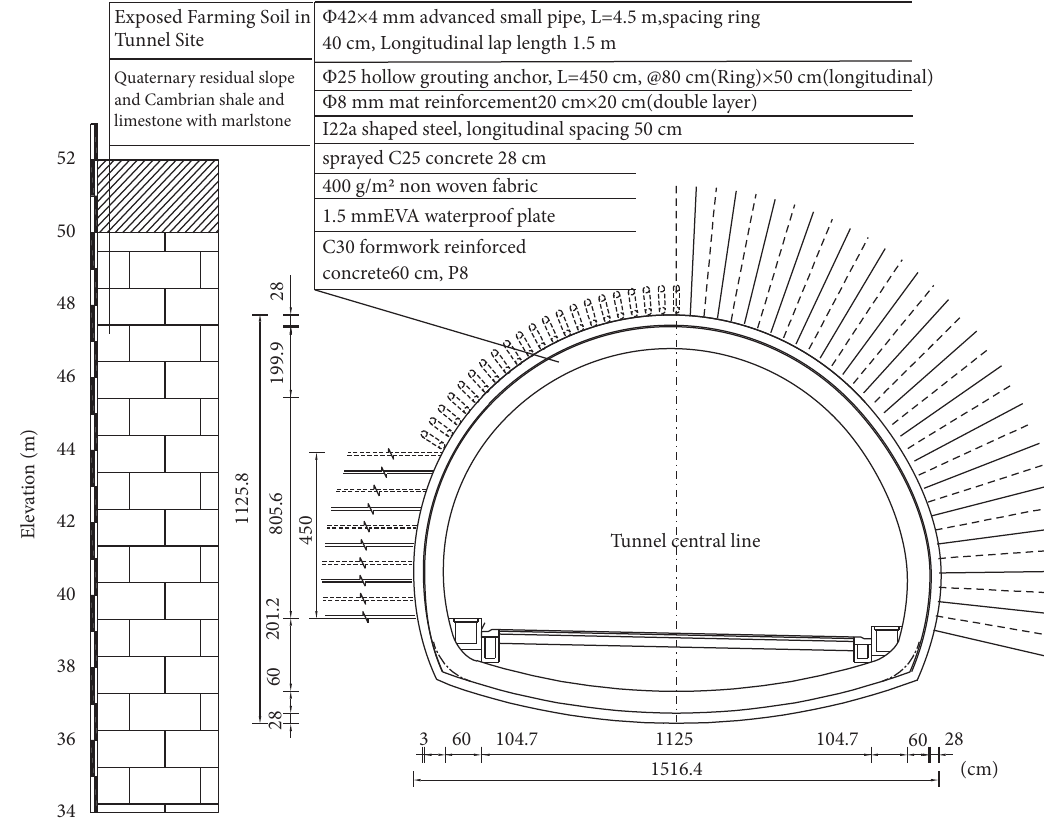
Figure 2: Geological conditions of tunnel site and section map of tunnel design.